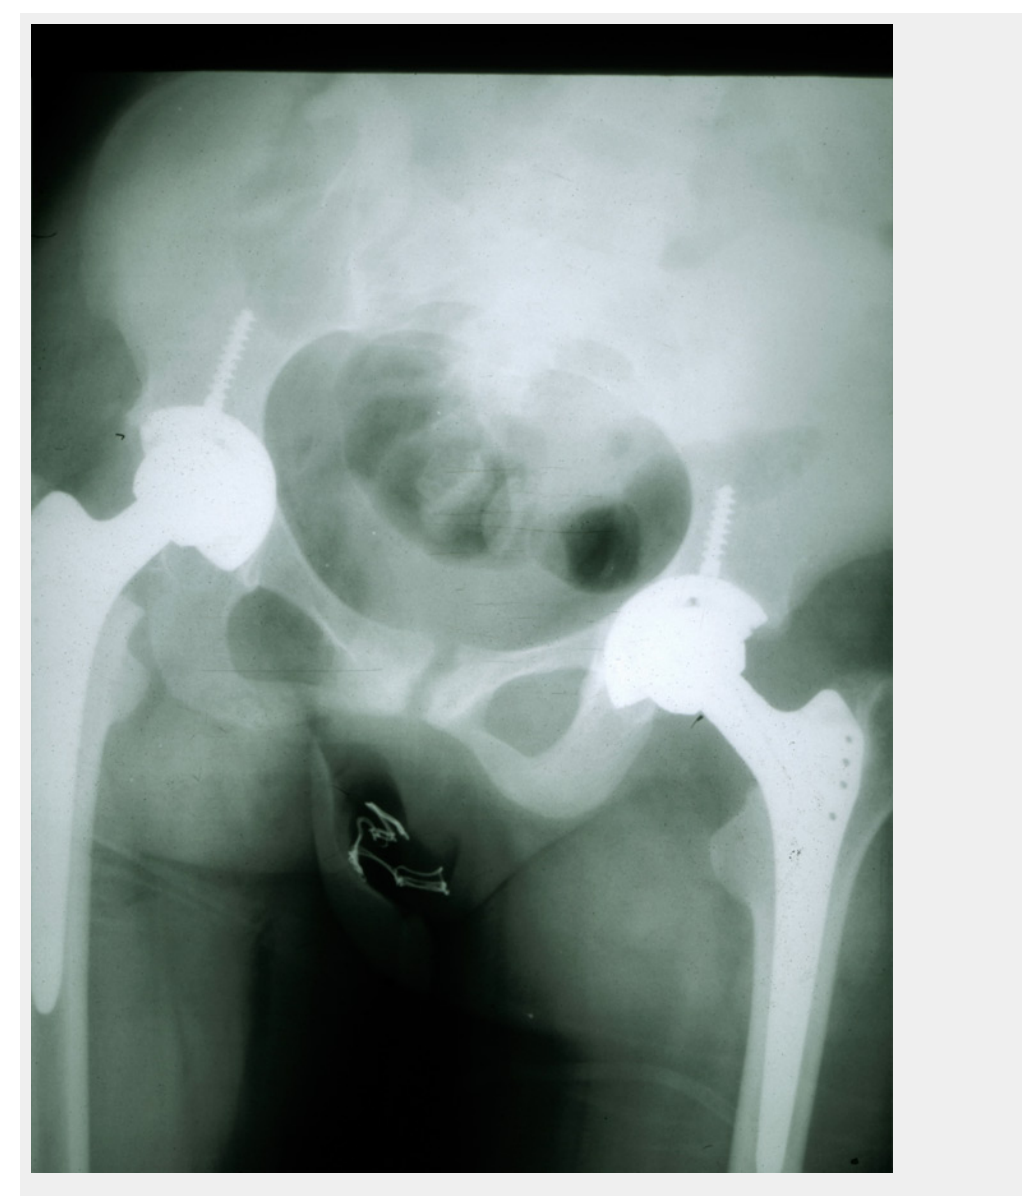
Figure 2 Hip replacement in a patient with